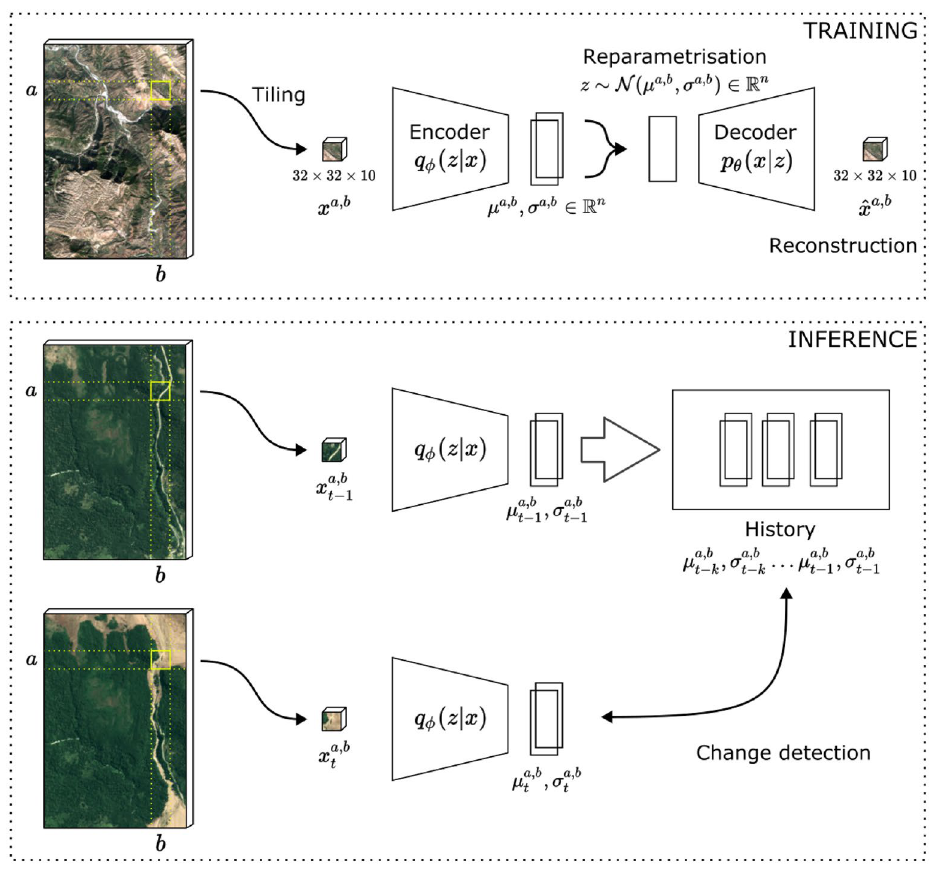
a , b Figure 3. Diagram of the proposed system. Tiles x of dimension 32 × 32 × 10 from the original Sentinel-2 multiband L1C data from the training dataset are fed to a VAE model. Here, a and b correspond to the location of the tile. The VAE is trained in an unsupervised fashion as its encoder learns to compress the tile in an a , b a , b Gaussian embedding representation µ and σ and the decoder to reconstruct them from there. At inference, a , b a , b only the trained encoder is needed as we compress evalutation dataset tiles x t into their embeddings µ t and σ a , b t which can be compared against an history of k embeddings extracted at the same location to assess whether the tile has changed significantly and prioritise for